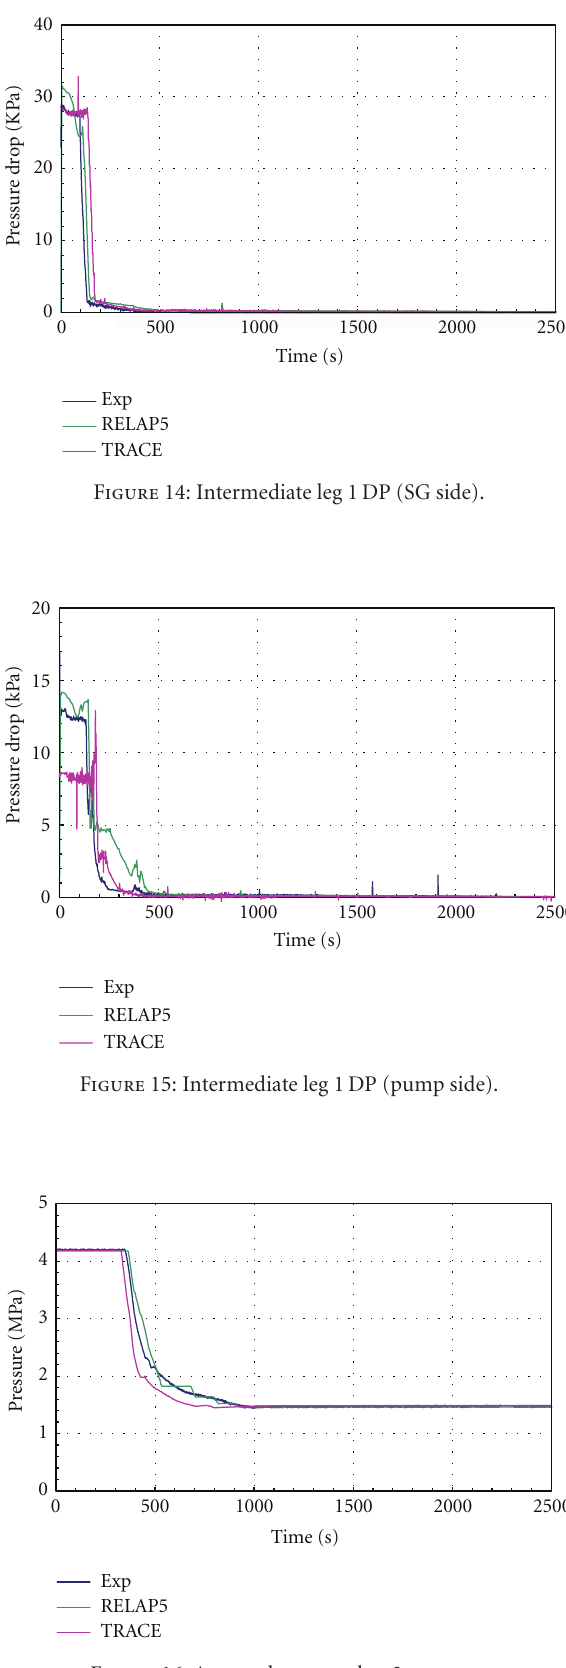
Figure 16: Accumulator number 2 pressure.